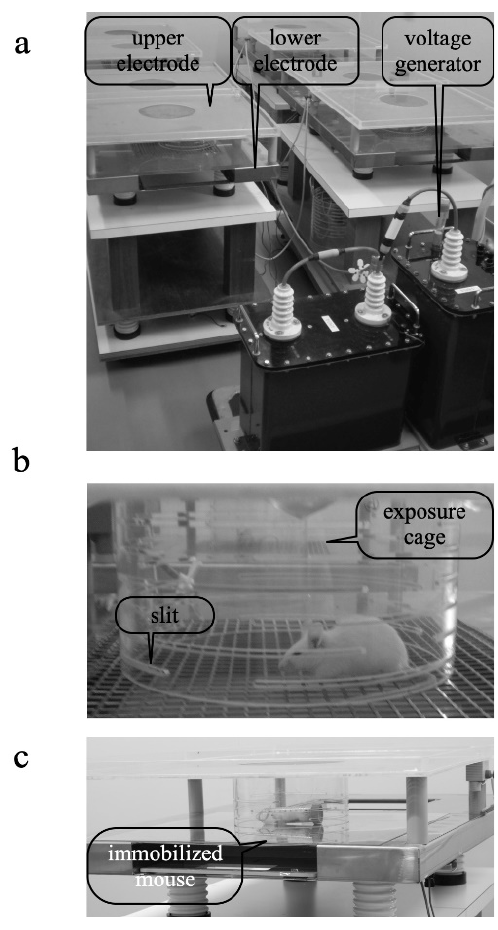
Figure 1. Appearance of EF exposure system. ( a ) High-voltage generator and parallel plate electrodes. ( b ) EF exposure cage with 100 mm × 5 mm slits spaced at 5 mm. ( c ) Centrifuge tube used to immobilize mice.